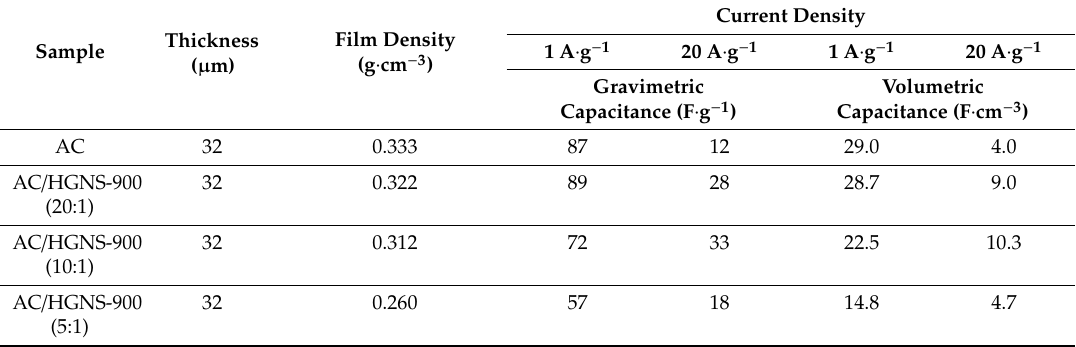
Film densities, gravimetric capacitances, and volumetric capacitances of various AC / HGNS